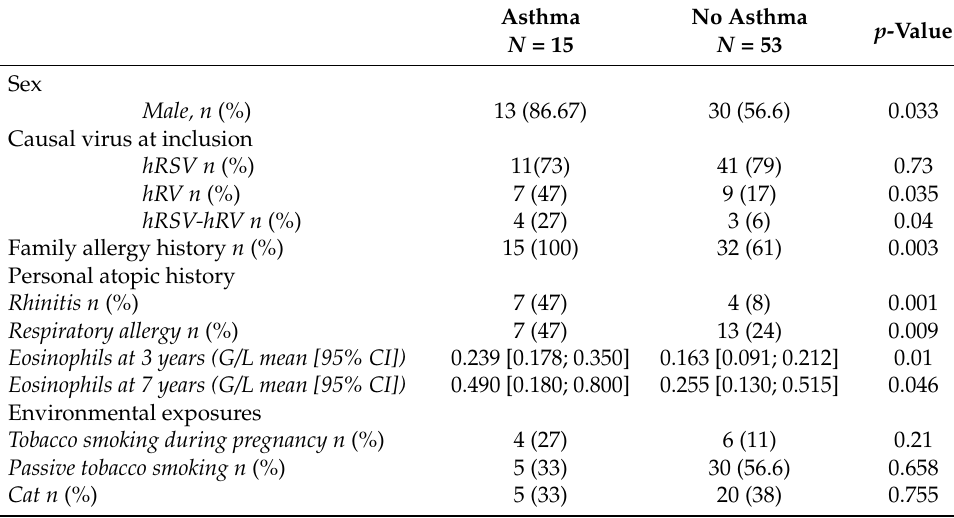
Table 3. Factors associated with asthma at age